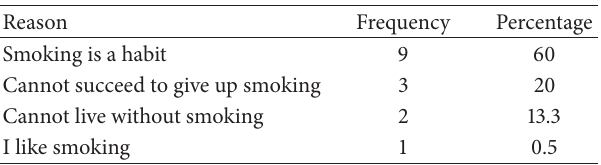
Table 2: Perceived reasons behind unwillingness to quit smoking ( 𝑛 = 15